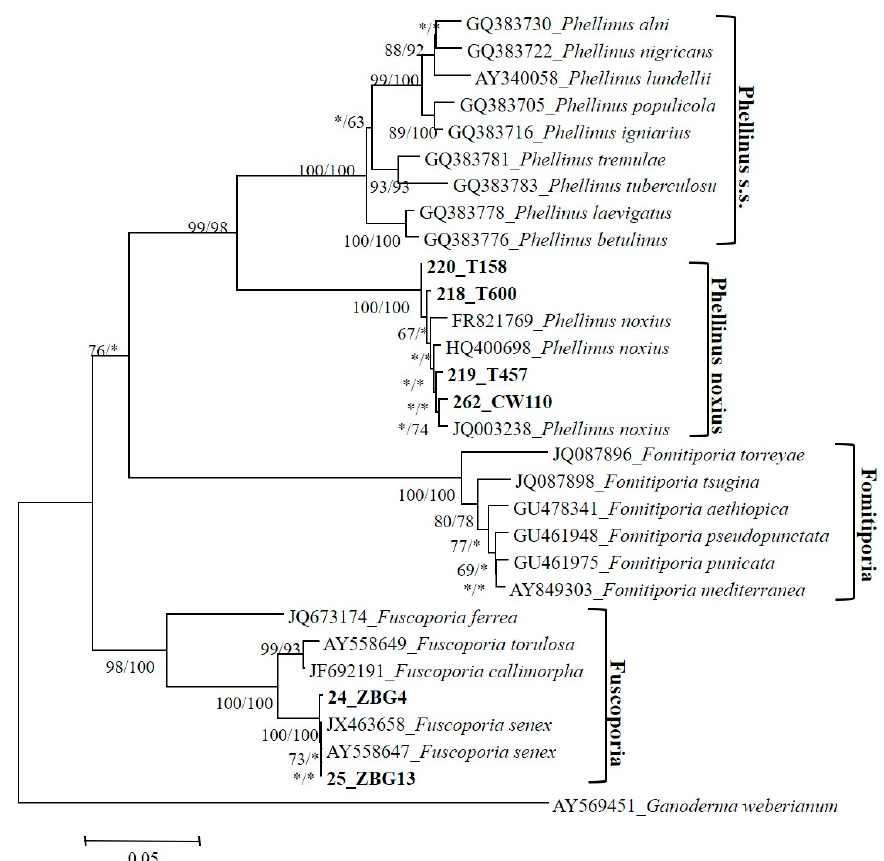
Figure 2. A neighbor-joining tree generated with ITS rDNA using MEGA 5.05 showing the phylogeny of Hymenochaetaceae species detected in this study. The numbers in front of the slashes show bootstrap (1000 replications) values (%) of the branches, and the numbers behind the slashes show Bayesian posterior probability (%) generated with BEAST v1.5.4. Values that are less than 50% were substituted with asterisk marks. The best model for Bayesian analysis was GTR + I + G, selected using MrModeltest 2.2. Sequences in bold indicate fungal species obtained from this study.